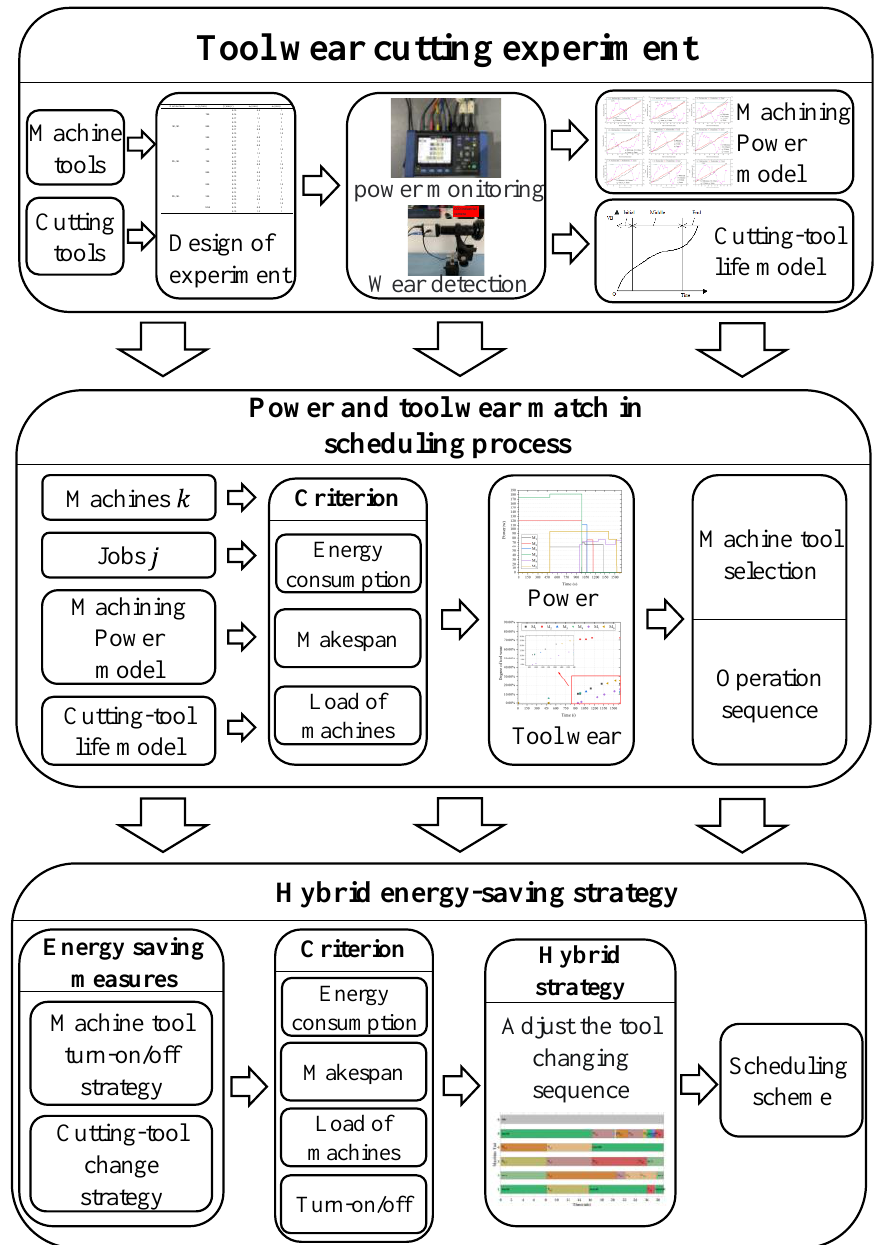
Figure 2. Energy-saving scheduling research route.